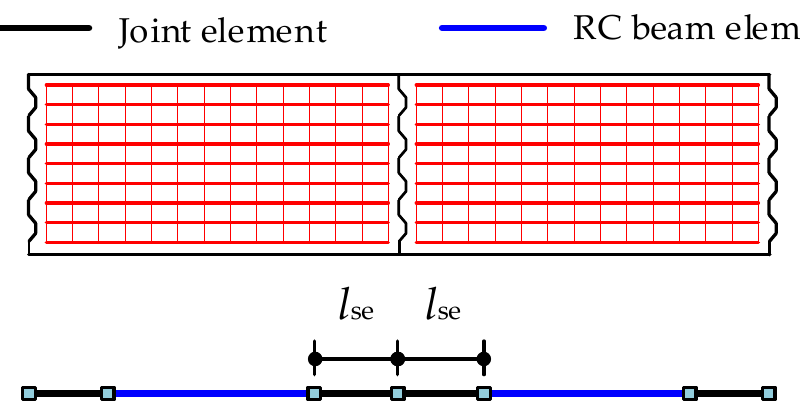
Figure 3. Modeling method of concrete beam segments.